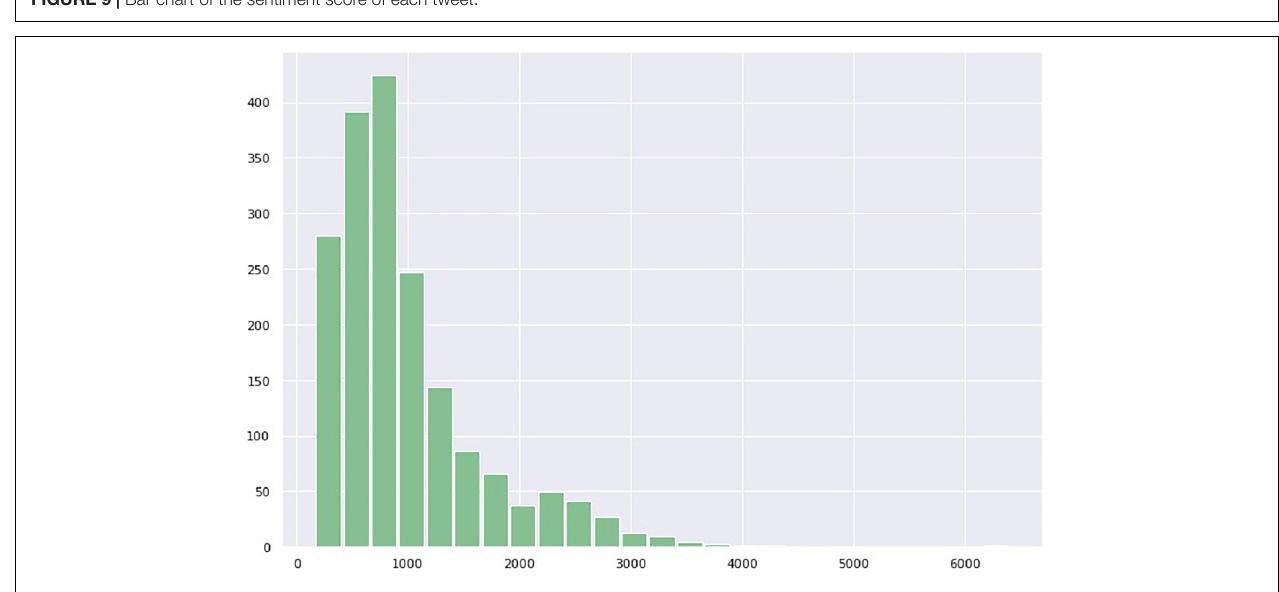
FIGURE 10 | Histogram of the amount of twitter per